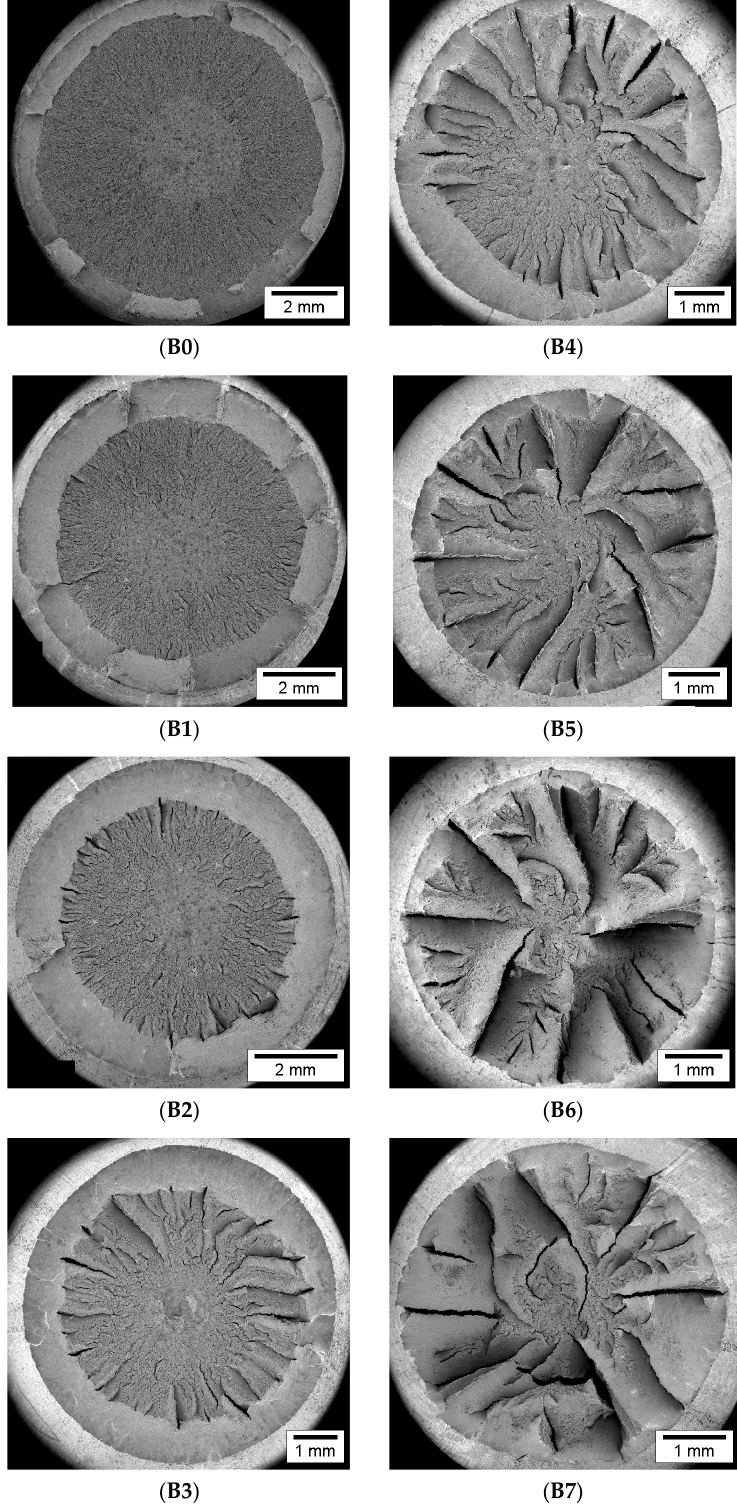
Figure 9. Evolution with drawing of MFMs of drawn wires corresponding to the family B.